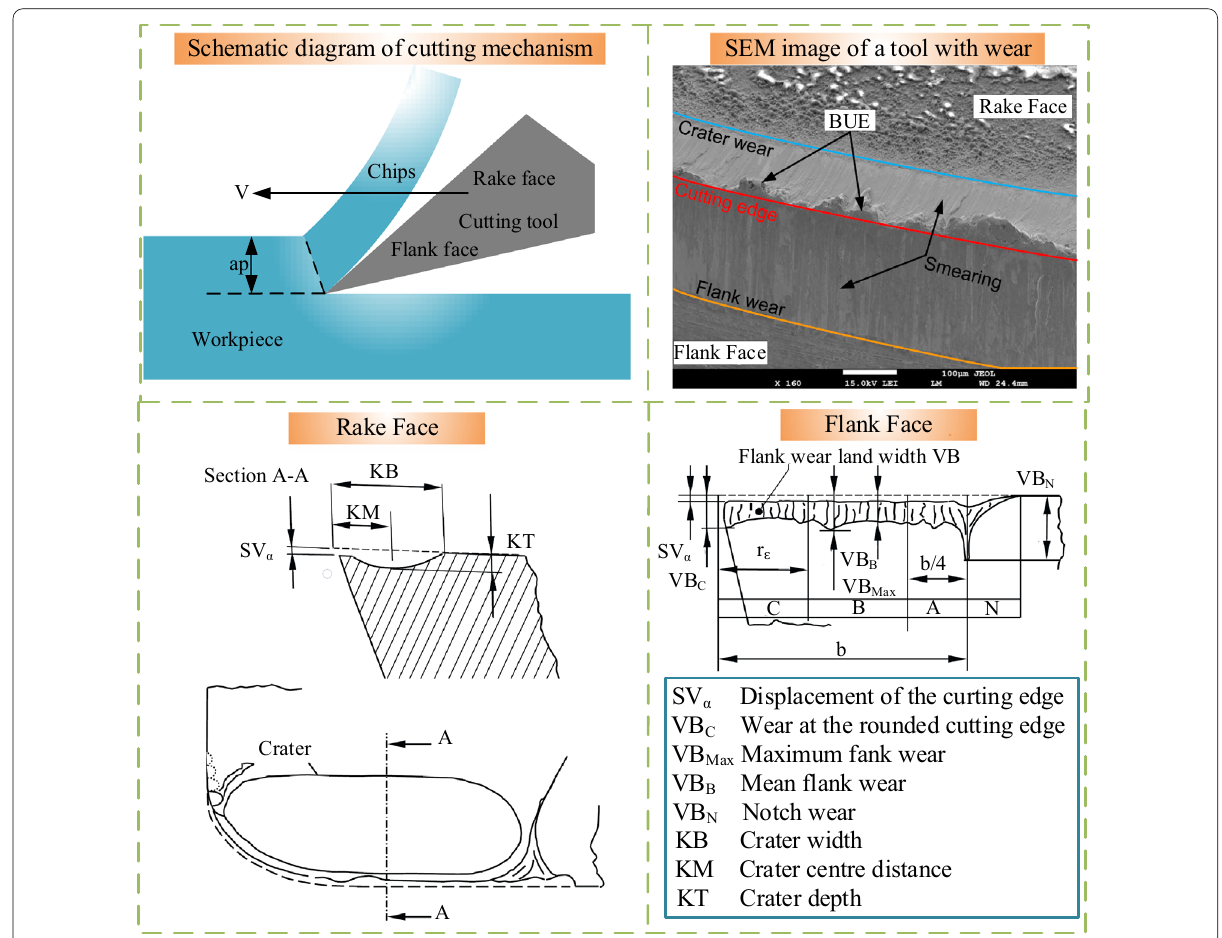
Figure 3 Cutting mechanism and tool